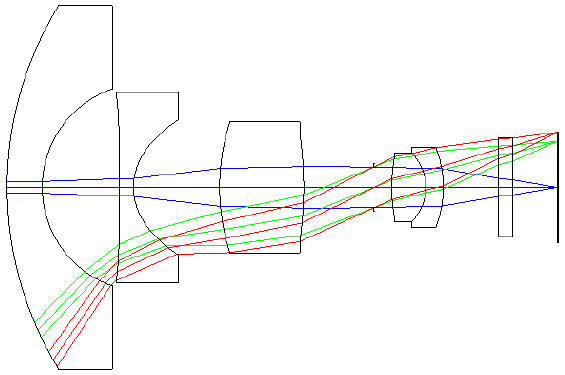
Figure 9. Design of a miniaturized wide-angle fisheye lens using a polymethyl methacrylate (PMMA) aspheric lens to replace a glass spherical lens.